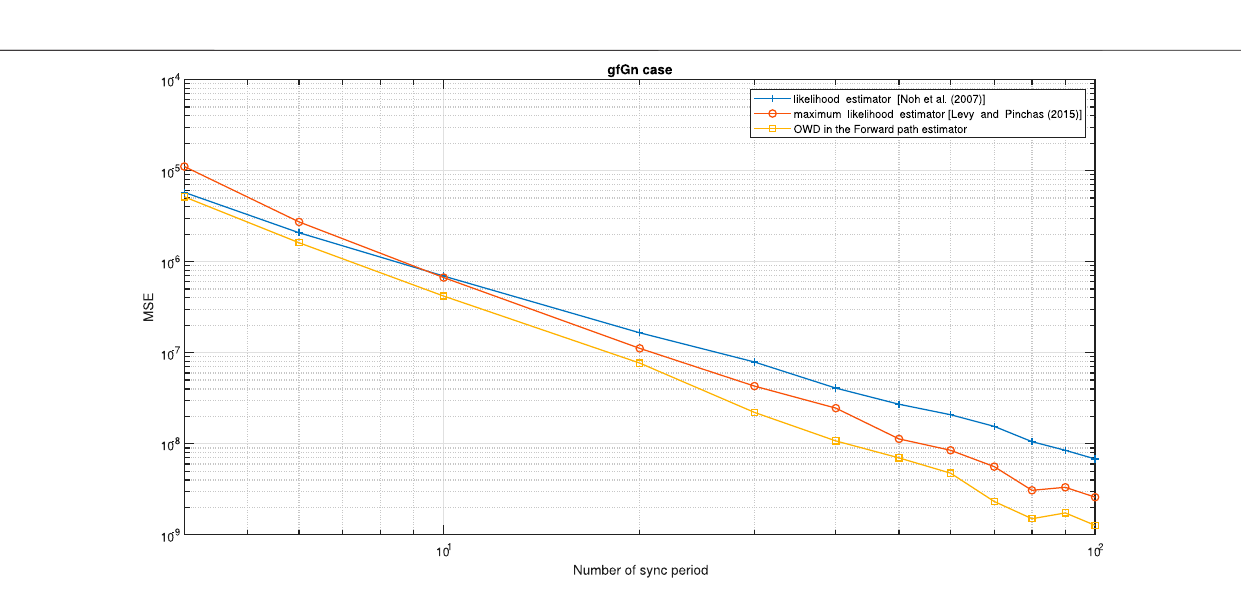
FIGURE 9 | Performance (MSE) comparison between the OWD clock skew estimator for the Forward path ( Eq. 61 ), likelihood clock skew estimator proposed by Noh et al. [5] and maximum likelihood clock skew estimator proposed by Levy and Pinchas [7]. The PDV is an gfGn process. α = 50 ppm , Q = 5 ms , ) , H =0.95, a = 0.08, d σ 2 (cid:2) 4 e − 8 [ sec 2 ] , σ 2 (cid:2) 1 . 6 e − 7 [ sec 2 ] .The results wereobtainedfor 100Monte-Carlotrails. T syn (cid:2) 15 . 6 ms ( 64 packet ω 1 ω 2 ms =5.5 ms , d sm = 5 ms , sec